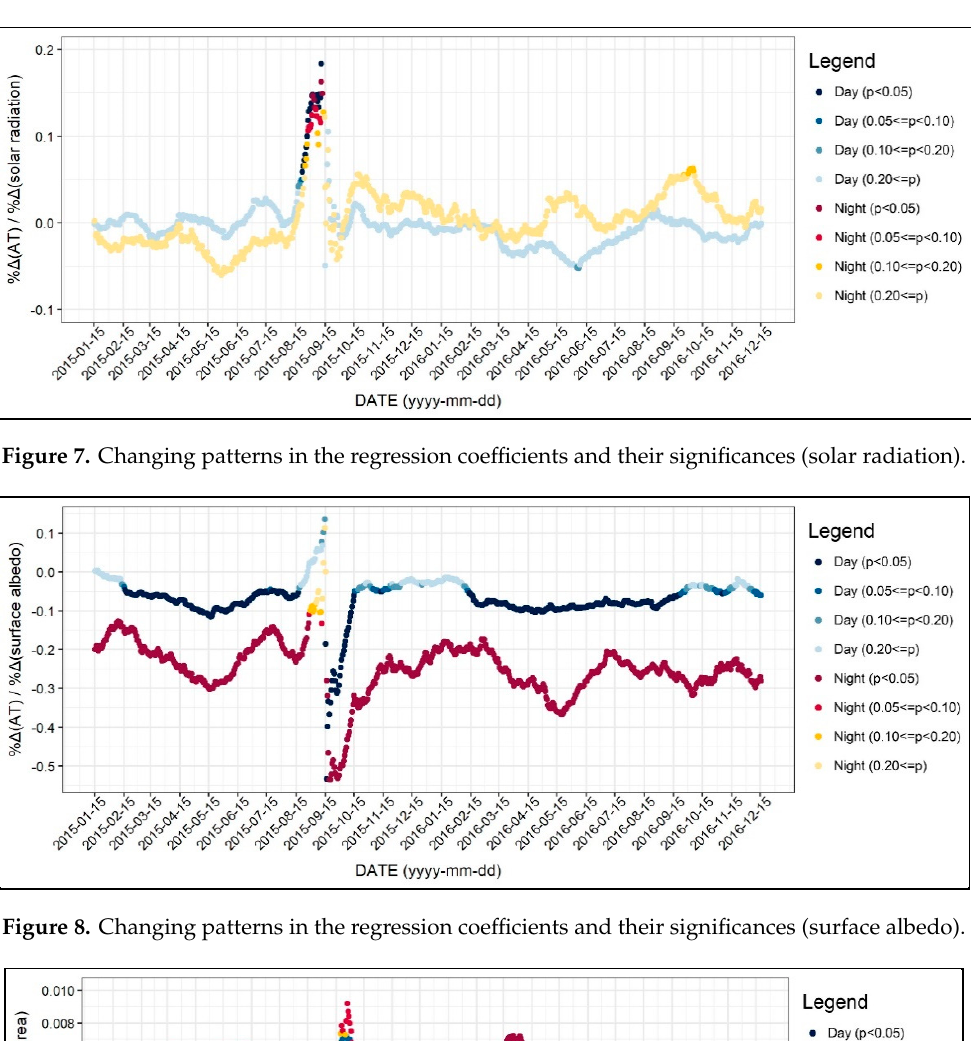
Figure 7. Changing patterns in the regression coefficients and their significances (solar radiation).